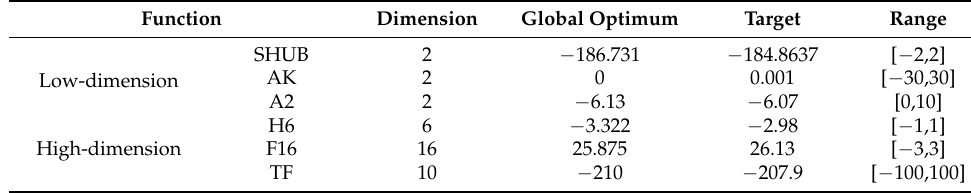
Table 1. Details of the benchmark